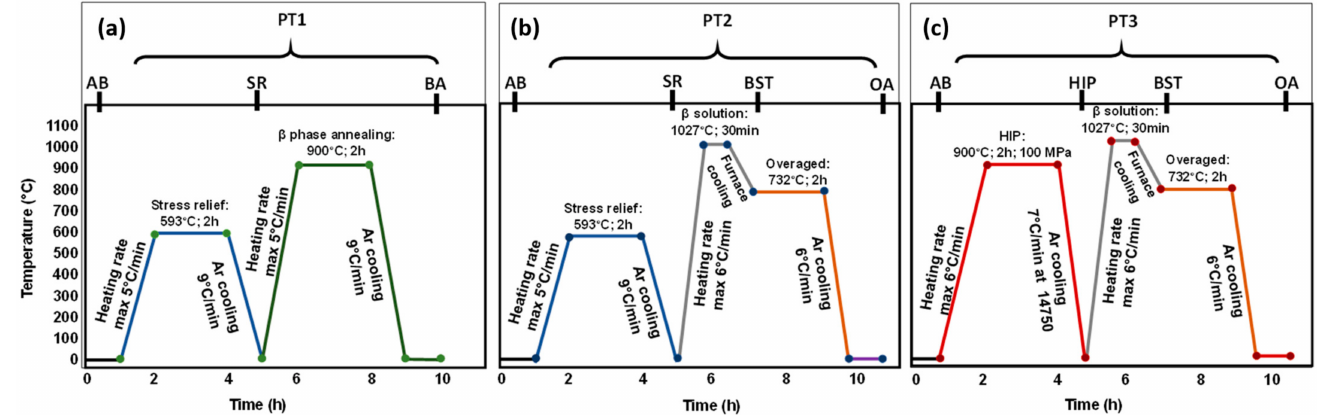
Figure 2. Three post-processing protocols used in this study. ( a ) PT1 corresponds to a two-step SR + BA treatment, ( b ) PT2 corresponds to a triple-step SR + BST + OA treatment, and ( c ) PT3 corresponds to a triple-step HIP + BST + OA